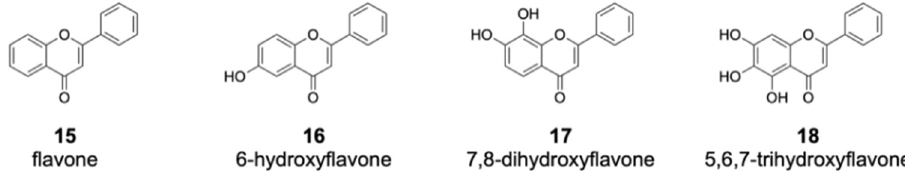
Figure 4. Members of the flavone group that were not enzymatically converted by DklH. The compounds 15 and 16 are characterized by the absence of a hydroxyl group at position 7. For the flavones 17 and 18 , one of the favourable halogenation positions, either 6 or 8, are substituted with a hydroxyl group.